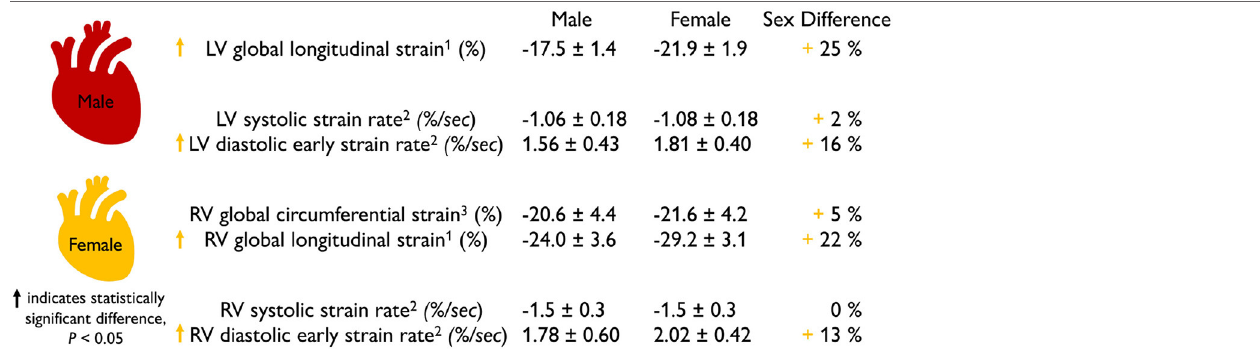
TABLE 5 | Sex differences in athlete’s myocardial